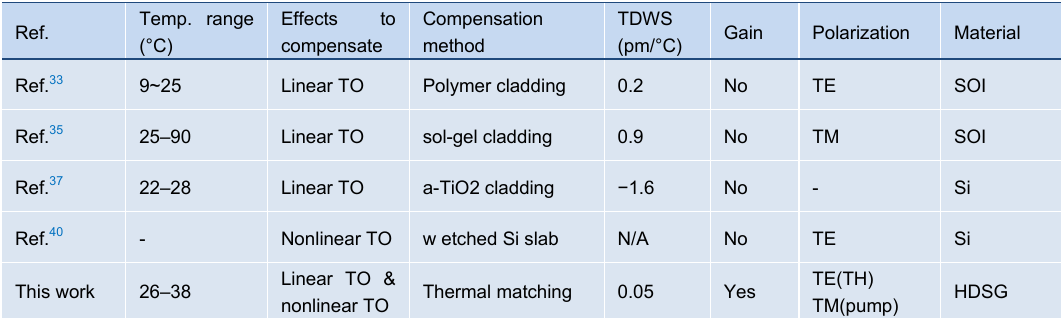
Table 2 | Comparison of athermal TDWS schemes using different micro resonators.